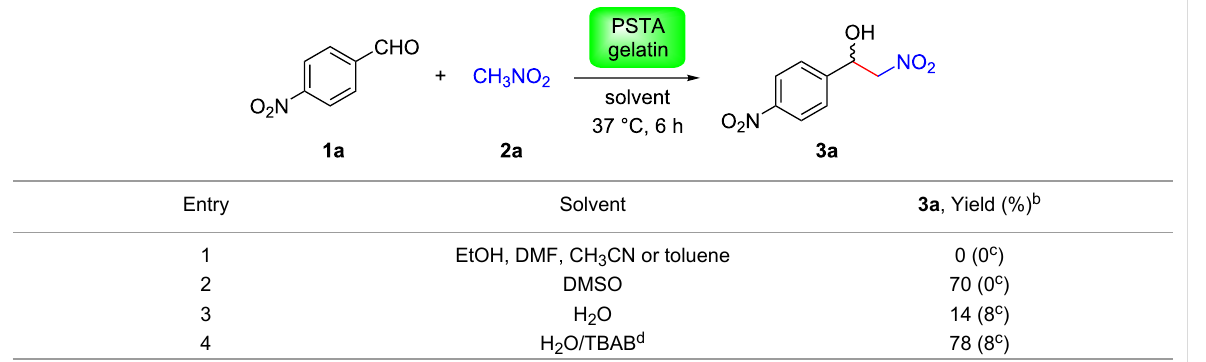
Table 1: Solvent-screening study for gelatin-mediated Henry reaction. a